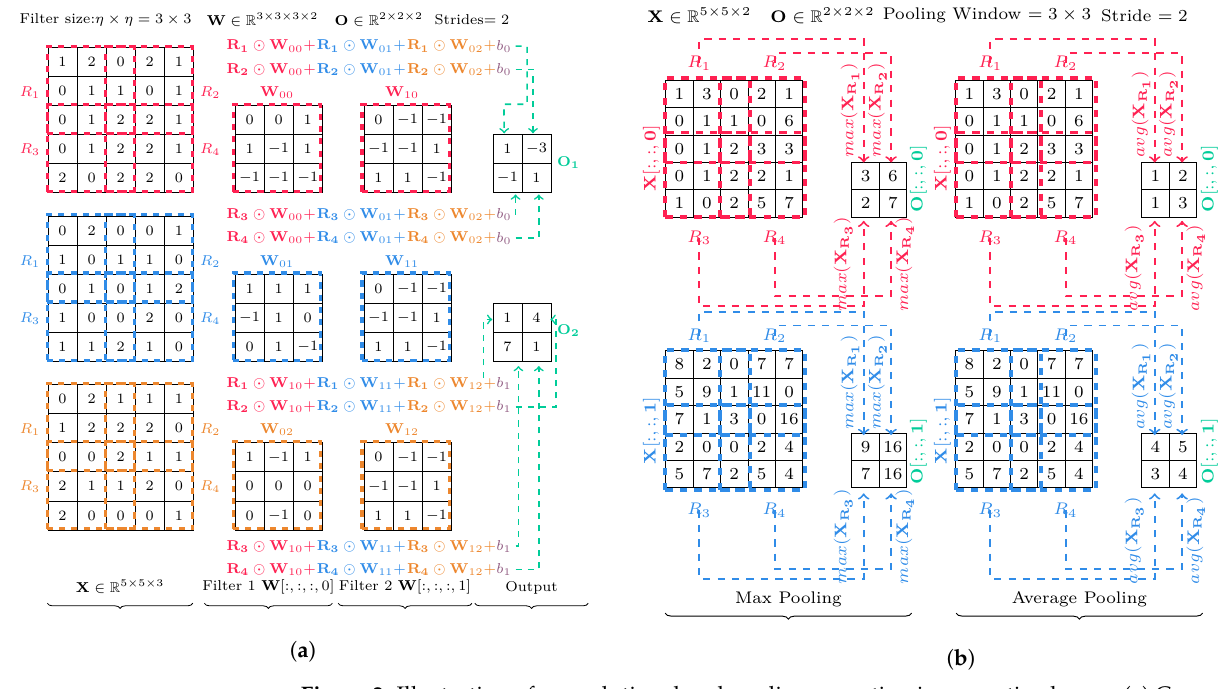
Figure 2. Illustration of convolutional and pooling operation in respective layers. ( a ) Convolution operation in CNN; ( b ) Average and Max pooling operation in